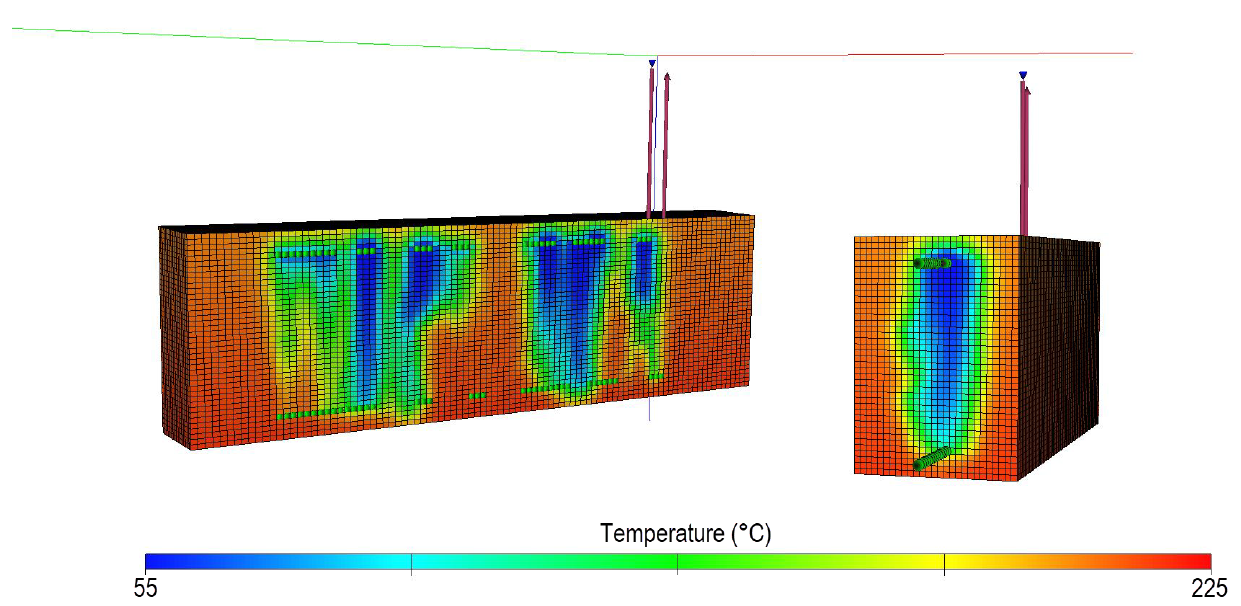
Figure 11. Temperature distribution in the SRV after 10 years of simulation (reference case) [2].